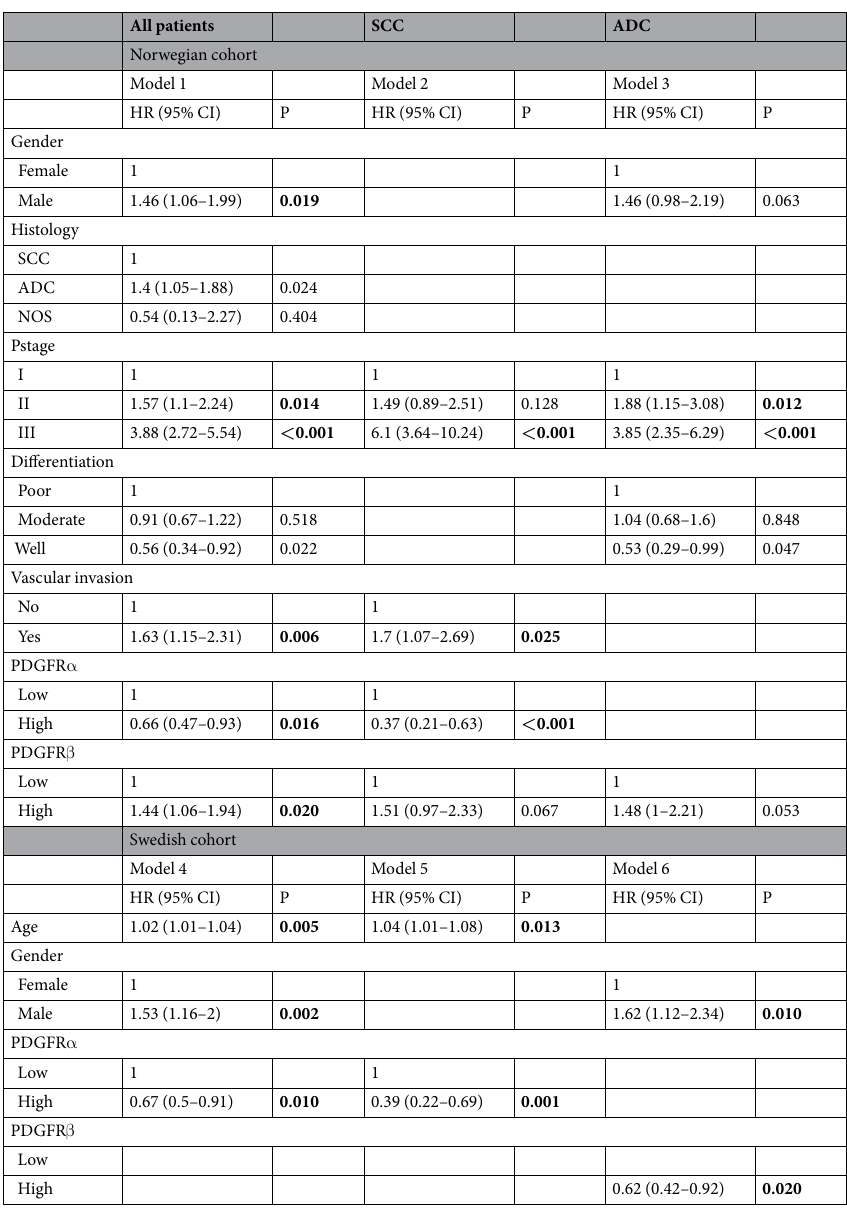
Table 4. Multivariable analysis of clinicopathological variables, PDGFR α and PDGFR β in the overall cohorts (Models 1 and 4) and in the SCC and ADC subgroup (Models 2,3,5 and 6). Abbreviations: PDGFR, platelet- derived growth factor receptor; NSCLC, non-small cell lung cancer; SCC, squamous cell carcinoma; ADC, adenocarcinoma; NOS, not otherwise